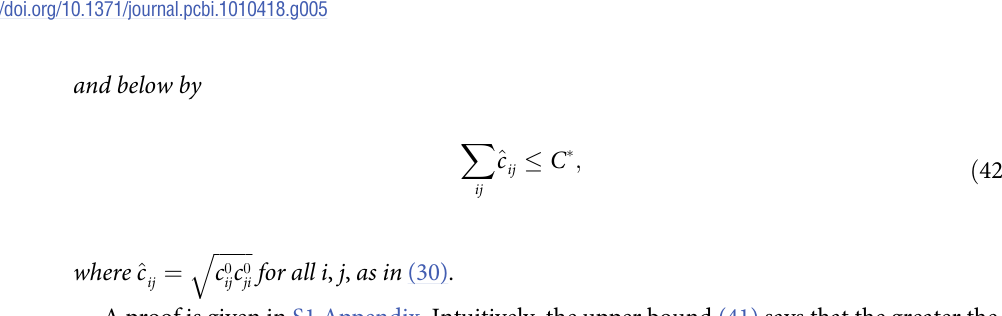
Fig 5. Dynamics of synaptic balancing in a 12-neuron ring network with single perturbed synapse. (a) . Left: A ring network is at an initial equilibrium C � i with all synaptic costs equal to 1. Nodes indicate neurons; arrows indicate directed synapses. Center: Synapse A, from neuron j to i , is instantaneously potentiated to a synaptic cost of c 0 ¼ 3 . Right: Synaptic balancing relaxes to a new ij equilibrium C � f . Synapse colors and thickness indicate synaptic cost. Neuron colors indicate value of h � f according to color scheme of panel (c). (b) Time course of synaptic balancing following perturbation. Incoming synapses to neuron i (A and D) are weakened and outgoing synapses from neuron i (B and C) are strengthened. Incoming synapses to neuron j (B and E) are strengthened and outgoing synapses from neuron j (A and F) are weakened. Synapses (H and G) that are distant from the site of perturbation respond more slowly than proximate synapses though they reach the same equilibrium values. (c) Three eigenmodes v 3 , v 5 , v 7 , with eigenvalues λ 3 , λ 5 , λ 7 , of the Laplacian matrix L 0 corresponding to the conductance matrix at the moment of perturbation. Color indicates mode value at each neuron. (d) Dynamics of h approximately decompose into the basis of Laplacian eigenmodes. The scalar projection of h onto each mode v is shown along with the quadratic approximation (39), using L 0 as Laplacian. Line color matches eigenvalue color in panel